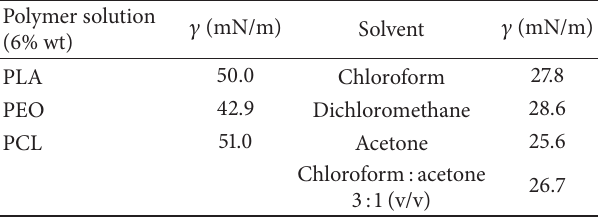
XRD-6000 diffractometer. Scans were carried out from 10 ∘ Table 2: Experimental values of surface tension in mN/m for the polymer solutions and solvents (23 ∘ C, 43%